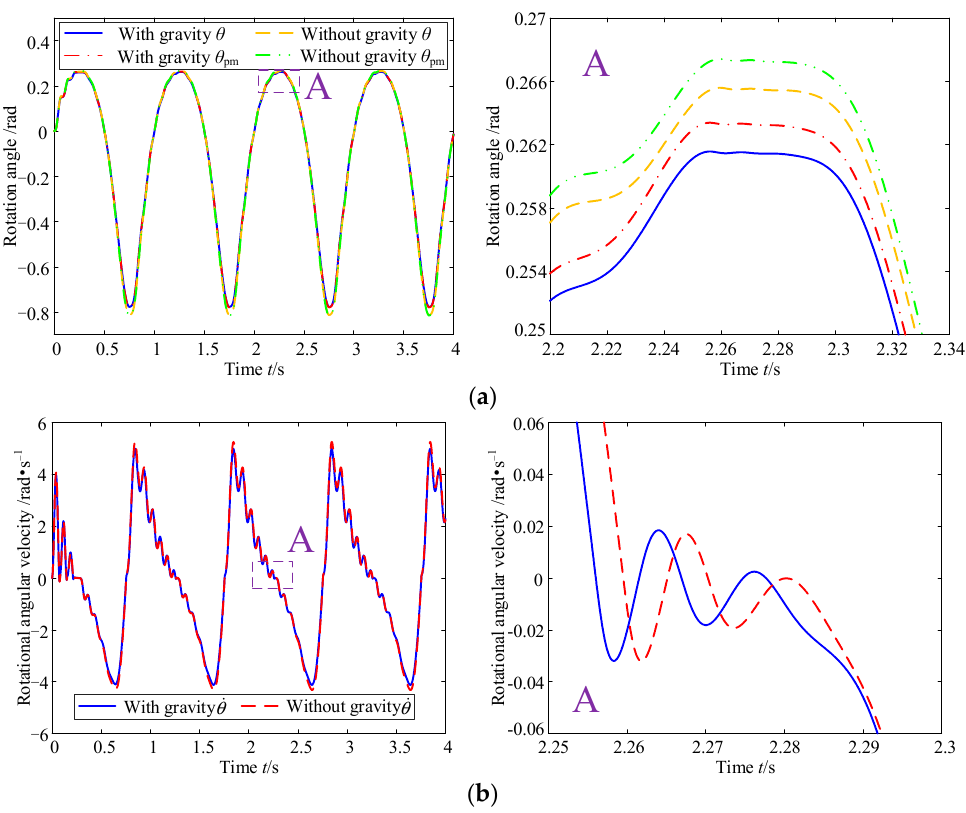
Figure 5. Effect of gravity on the dynamic performance of position motor systems at variable stiffness: ( a ) rotation angle and ( b ) rotational angular velocity.